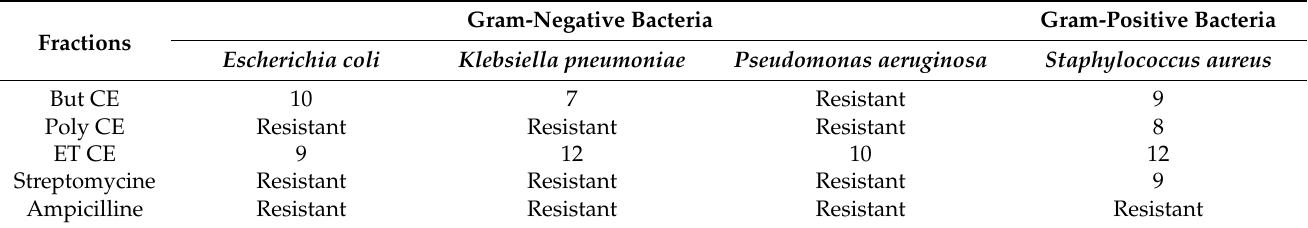
Table 6. Inhibition zone diameter of C. europaea fractions against bacterial species in (mm). Gram-Negative Bacteria Fractions Escherichia coli